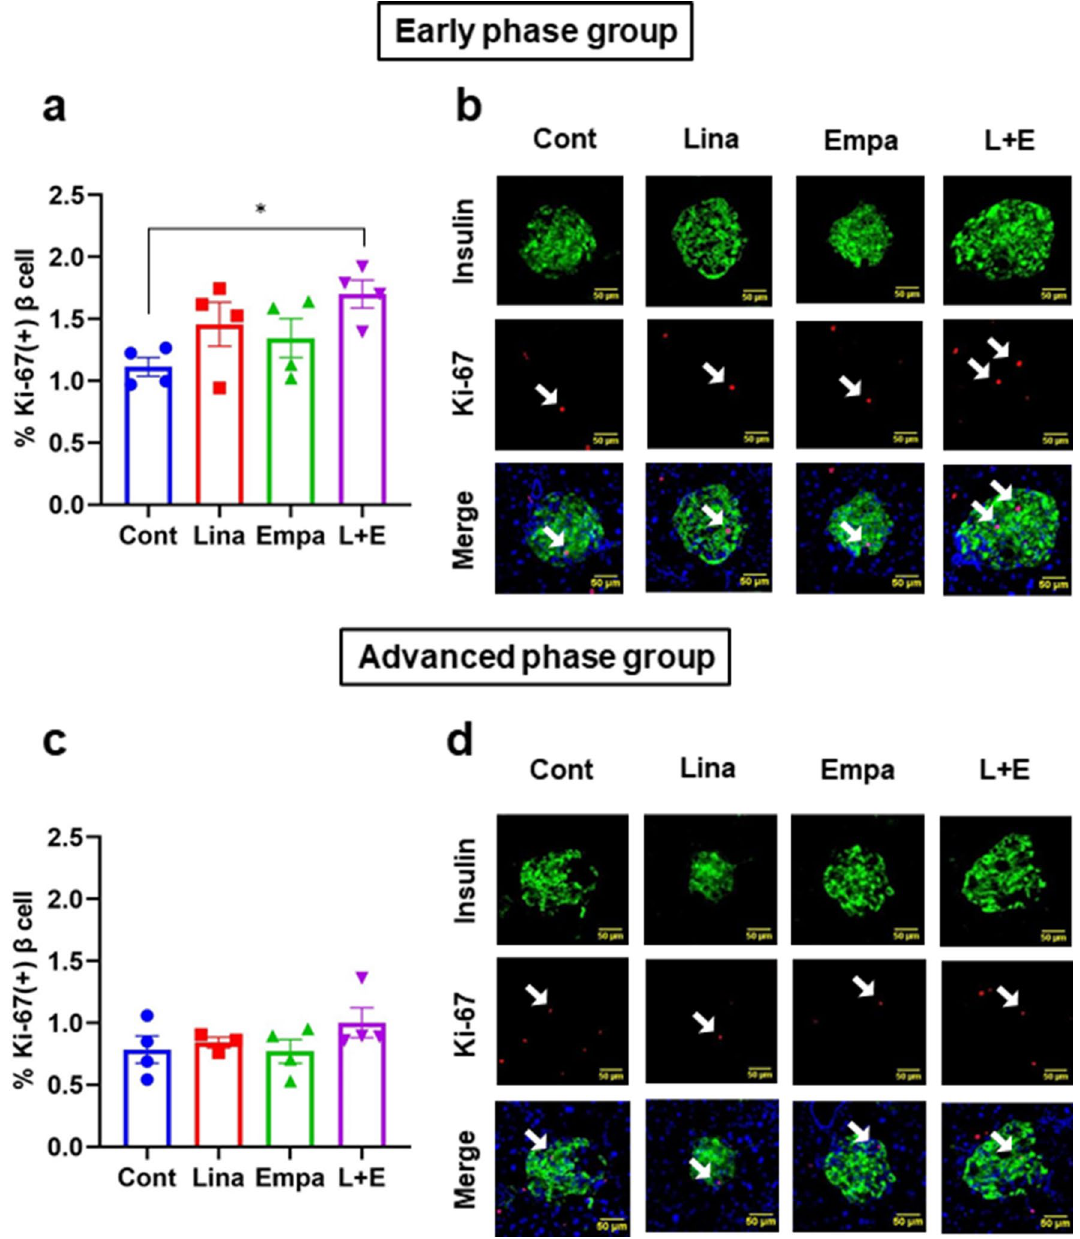
Figure 4. Ki-67 immunostaining in ( a , b ) an early phase and ( c , d ) an advanced phase of diabetes. ( a , c ) Quantification of Ki-67-positive β-cells (n = 4). ( b , d ) Representative images of Ki-67-positive β-cells. Scale bars: 50 μm. The multiple comparison was performed using the Tukey–Kramer method. Data are presented as mean ± S.D. *: p <